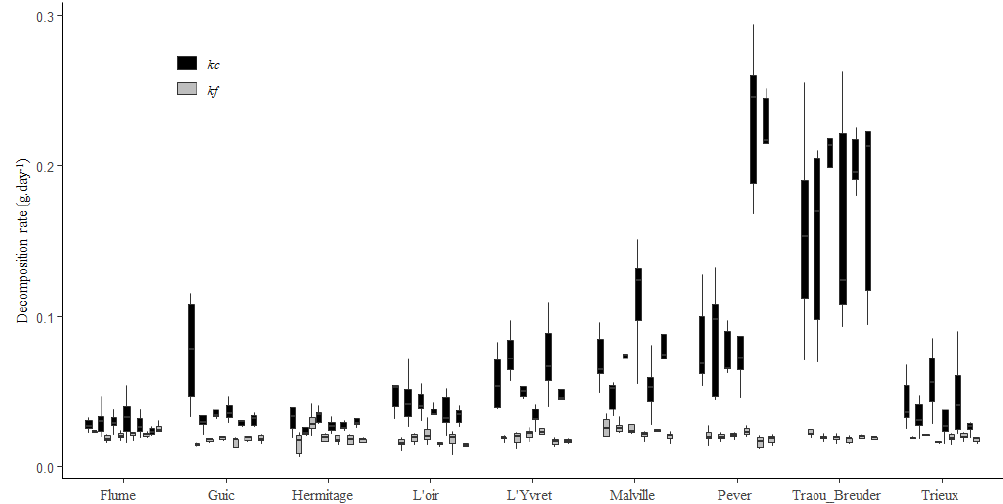
Figure 3. Mean ± SE in-stream variability measured by the coefficients of variation (CVs) of kc and kf for the nine streams. The ratio kf : kc was higher than the ratio λ F: kc in five streams (Le Guic, L’oir, Trieux, Hermitage, and Flume Figure 4). This suggests that microbial activities in these